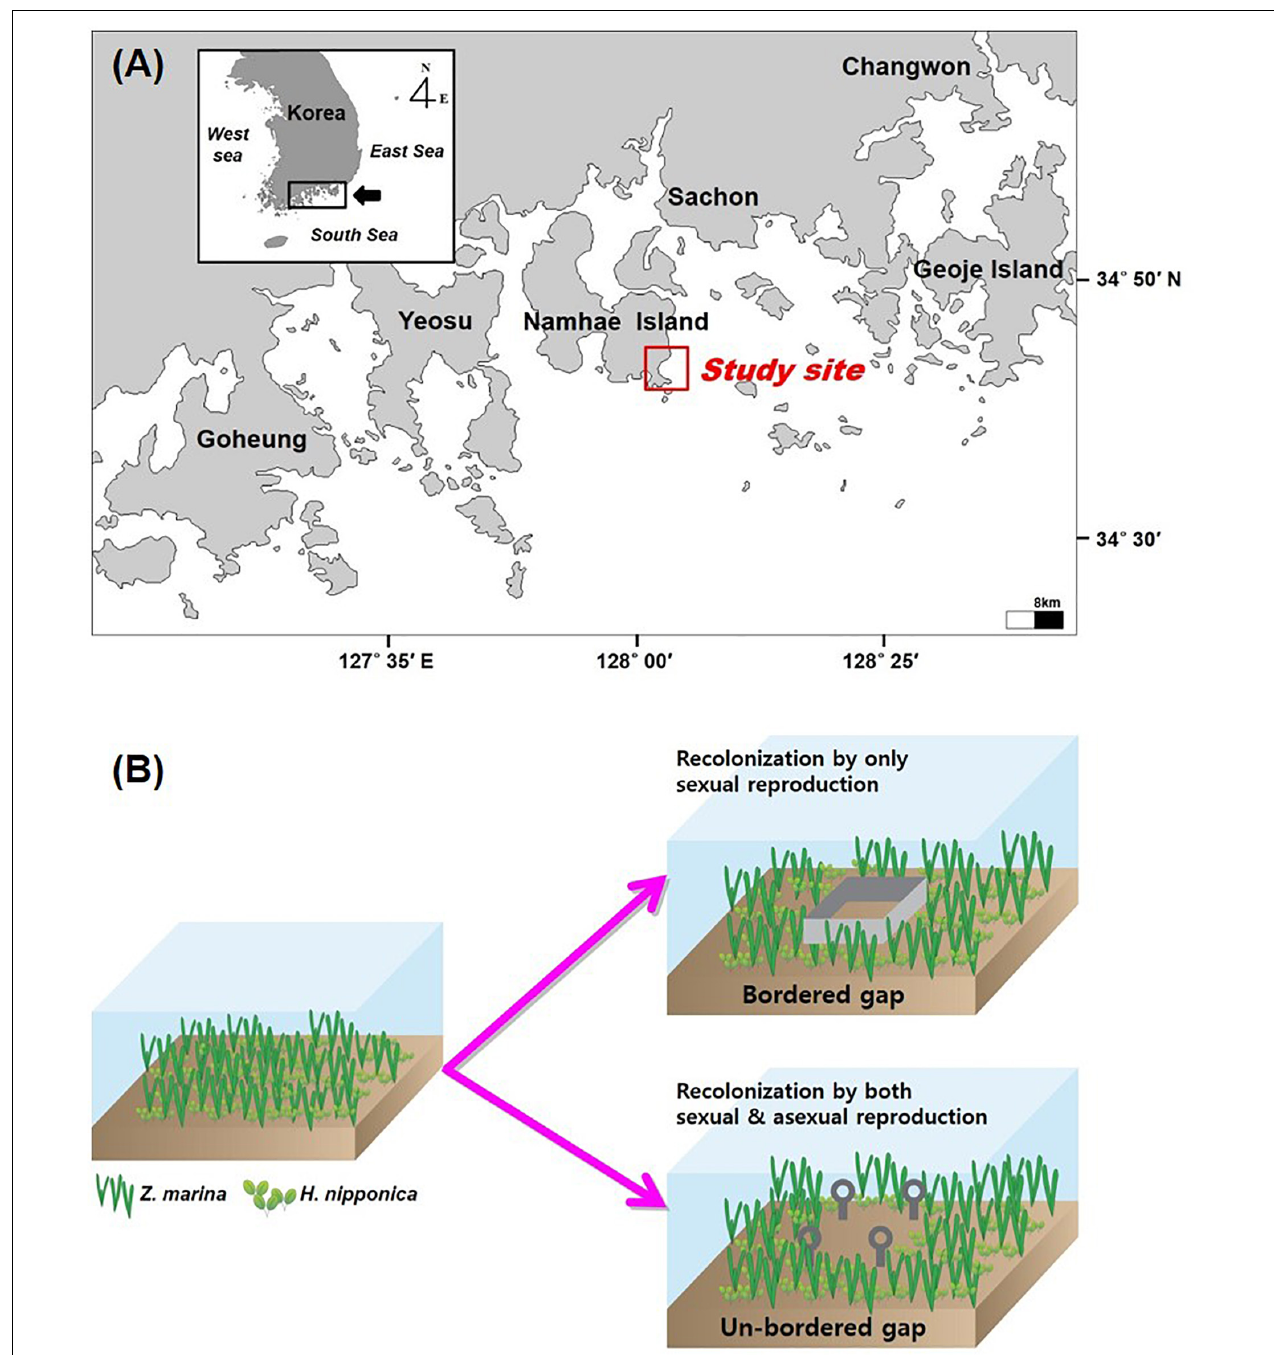
FIGURE 1 | Study site (A) and a diagram of the experimental design for the bordered and un-bordered gaps (B)